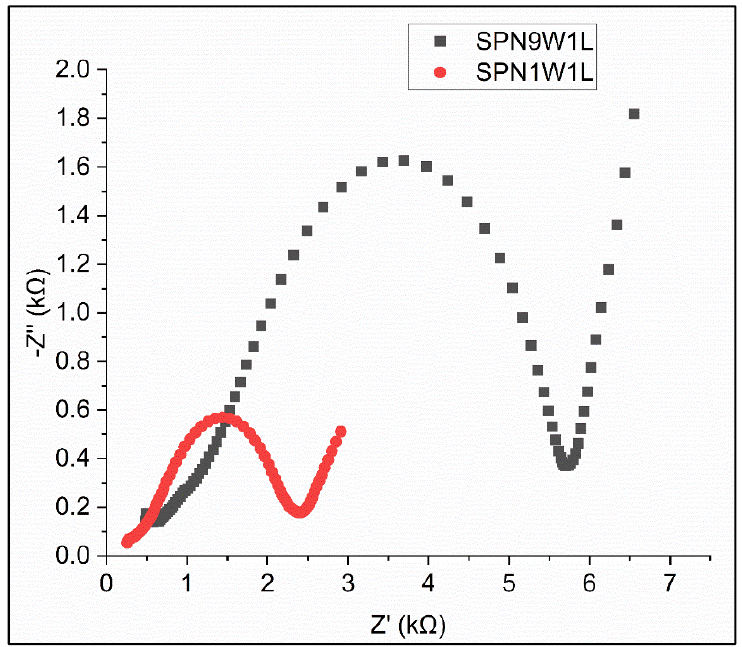
Figure 3. Nyquist plots of the SPNWL, Ni/W = 1:1 and the SPNWL, Ni/W = 9:1.